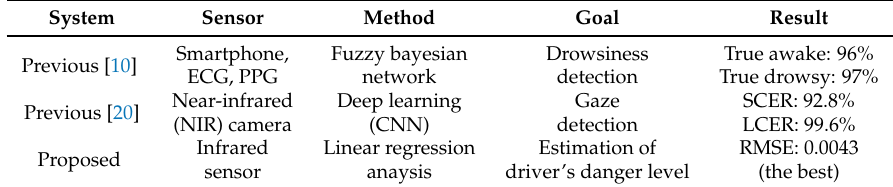
Table 6. Comparison of the proposed method with the previous research for safe driving. (CNN: Convolutional neural network, SCER: strictly correct estimation rate, LCER: loosely correct estimation rate, ECG: electrocardiography , PPG: